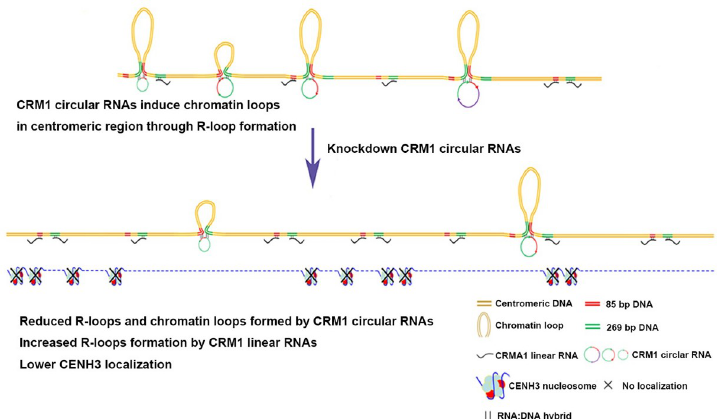
Fig 6. The model for roles of circular CRM1 RNAs in centromere structure and function. Circular CRM1 RNAs can bind to the chromatin through R-loops to induce chromatin loop formation. The chromatin binding of circular RNAs can repress the formation of R-loops by related linear RNAs. Higher numbers of R-loops and lower numbers of chromatin loops lead to lower levels of CENH3 localization in the centromere. CENH3, centromeric H3 variant; CRM, centromeric